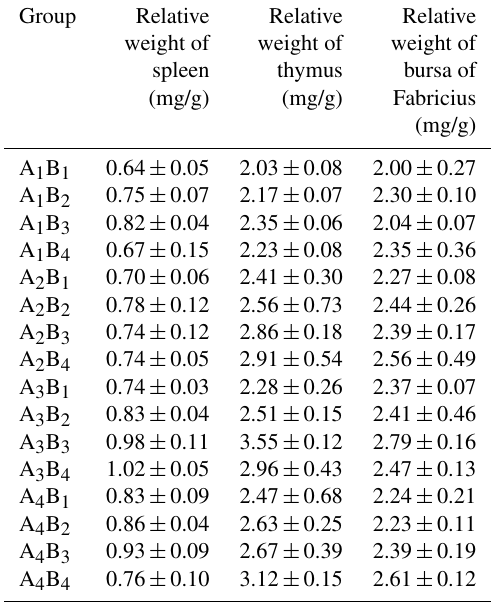
Table 3. The immune organ indexes of Arbor Acres broilers un- der low temperature conditions supplemented by glutamine and L-